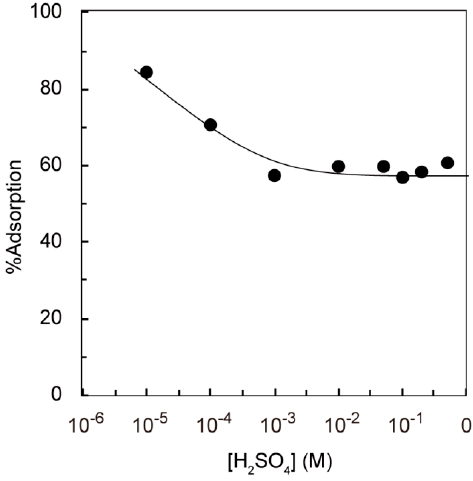
Figure 6. Effect of H 2 SO 4 concentration on the recovery of Ag(I) on the DTO ‐ microalgae. Conditions: Ag(I) concentration = 0.2 mM, CS(NH 2 ) 2 concentration = 0.05 M, weight of adsorbent = 10 mg, volume of test solution = 10 mL, temperature = 30 °C, and shaking time = 24 h.